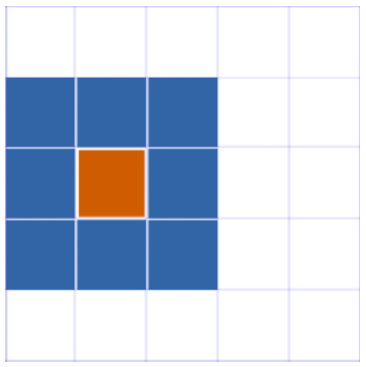
Figure 4. A pixel point with a Radius = 1.